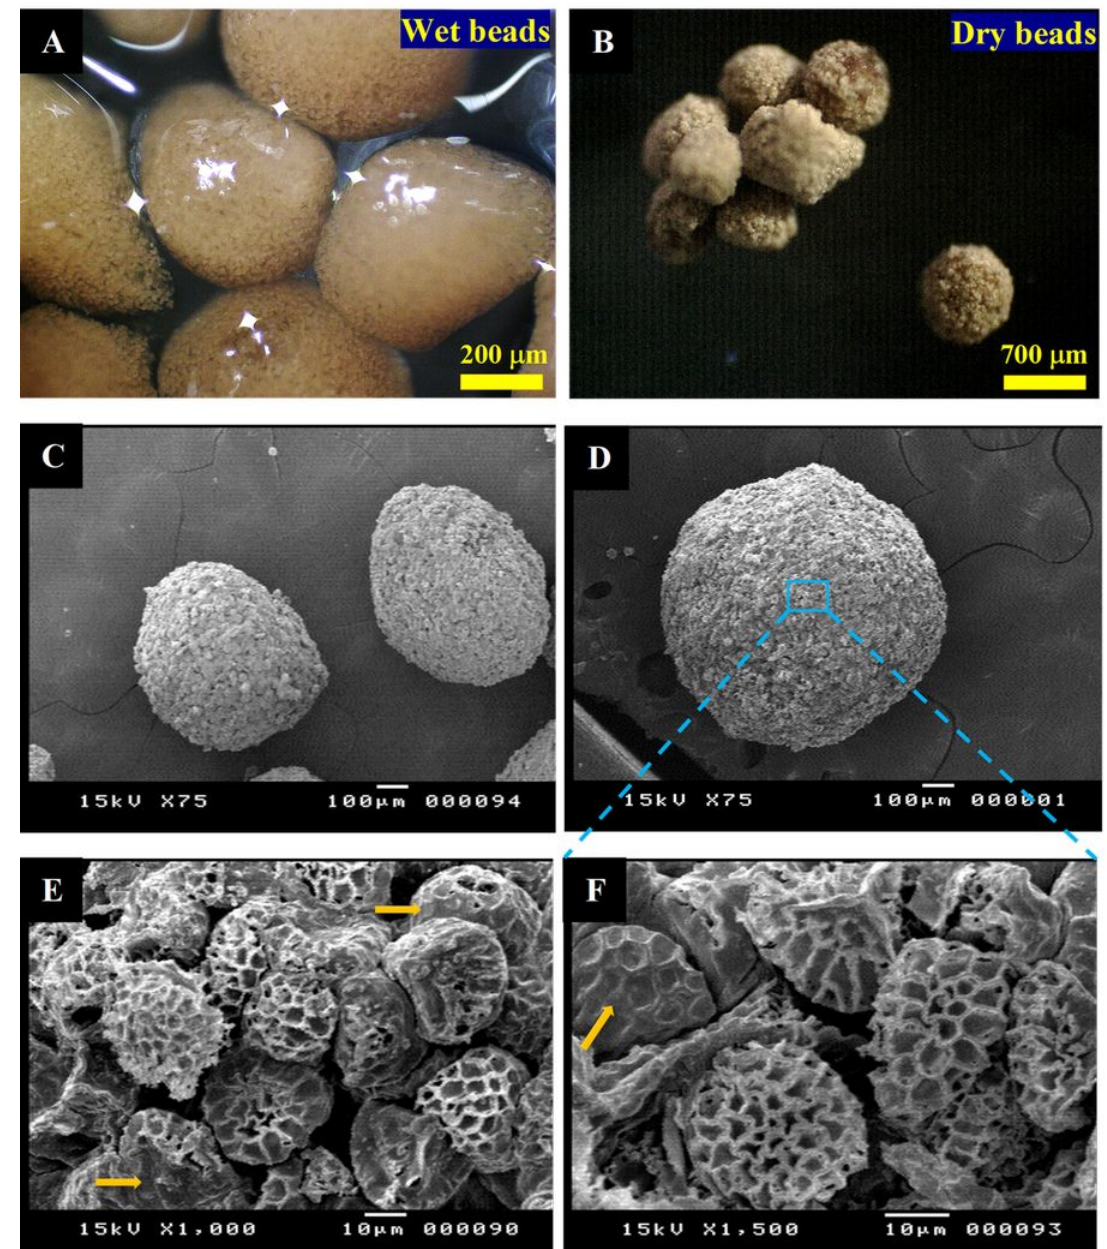
Figure 5. Optical and SEM images of MTF-loaded LCS-ALG beads showing the surface morphology. ( A , B ) Optical images of wet and dry beads. ( C , D ) SEM of beads showing their morphology and shape. ( E , F ) Surface of one bead at a higher magnification showing MTF-loaded LCS microcapsules with the ALG covering (arrows).